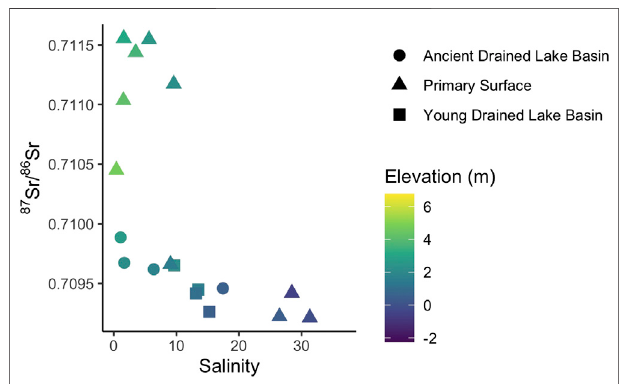
FIGURE 7 | Relationship between porewater 87 Sr/ 86 Sr and porewater salinity. Color indicates elevation (m) relative to mean local sea level and symbols indicate the geomorphic terrain